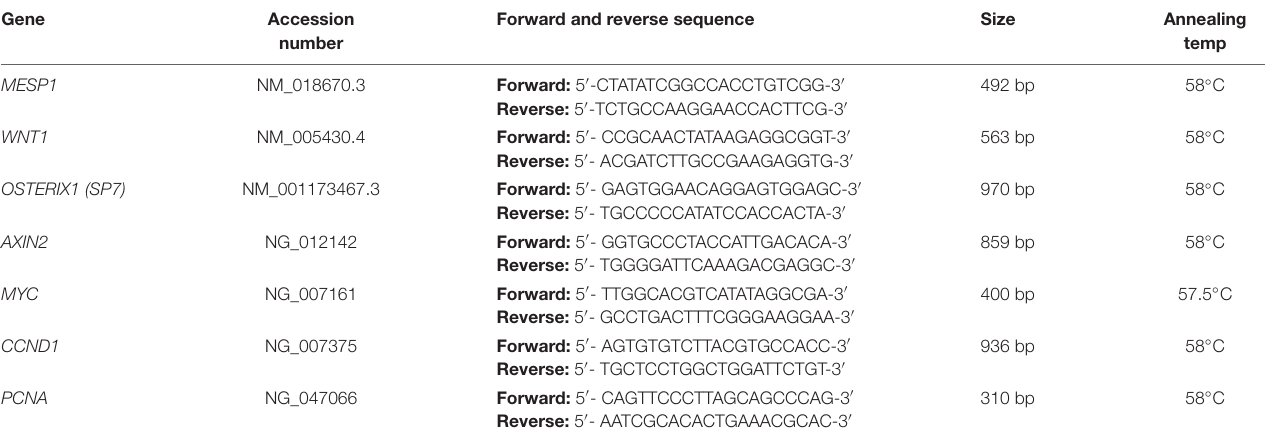
TABLE 1 | List of primers sequence and their annealing temperature. Gene Accession Forward and reverse sequence number